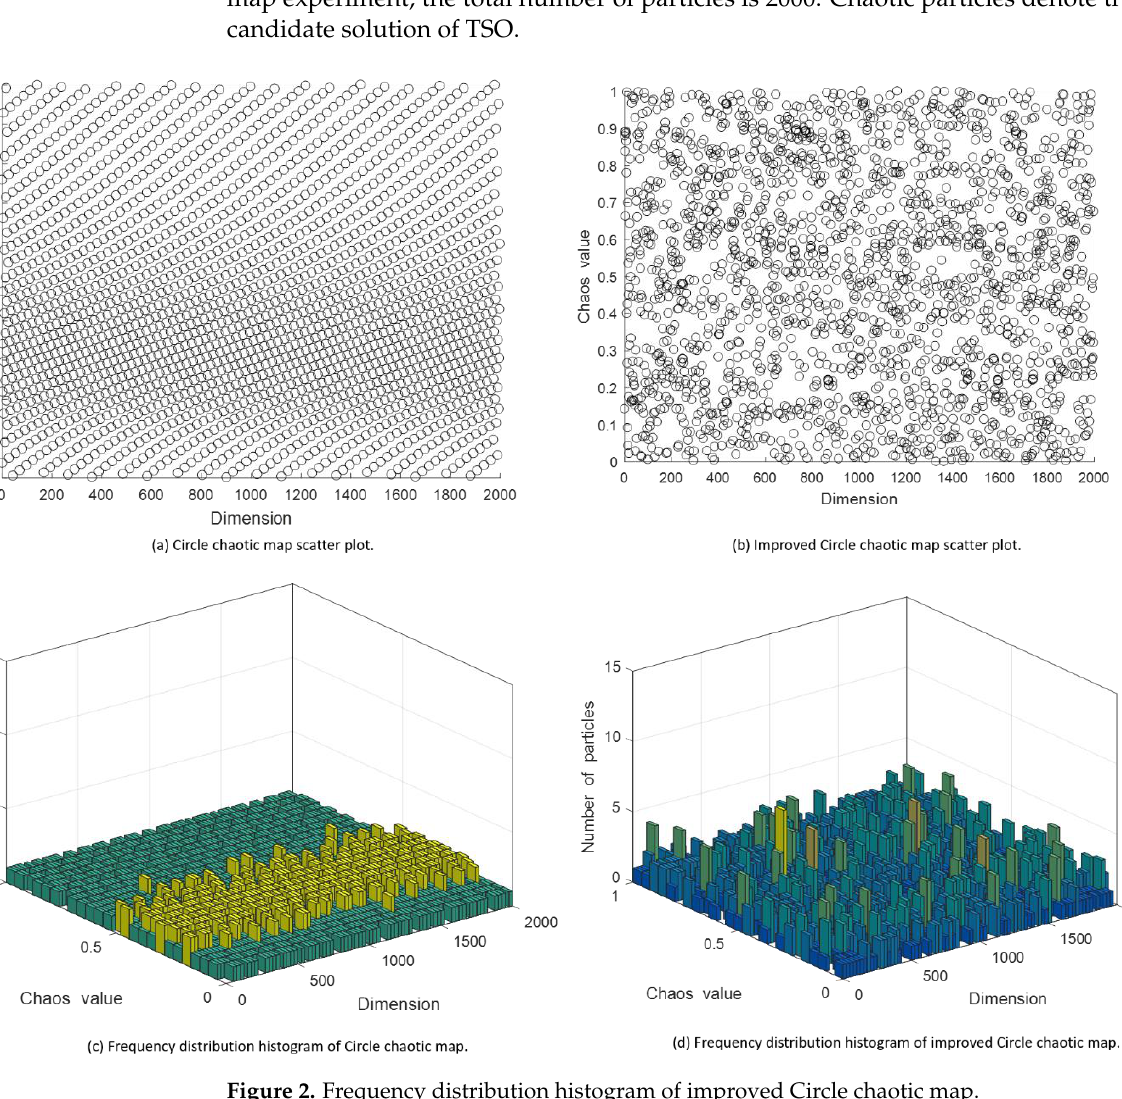
Figure 2. Frequency distribution histogram of improved Circle chaotic map.